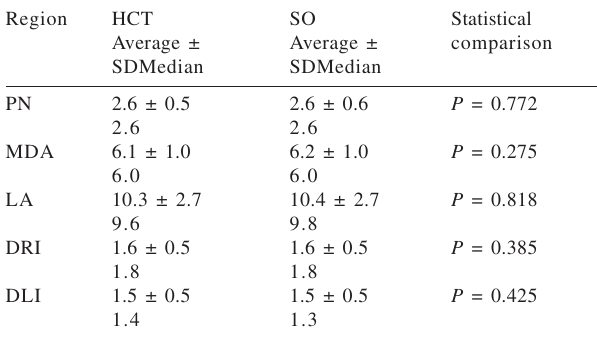
Table 3 - Comparison between helical computerized tomography (HCT) measurements and surgical observation (SO) (n = 20).